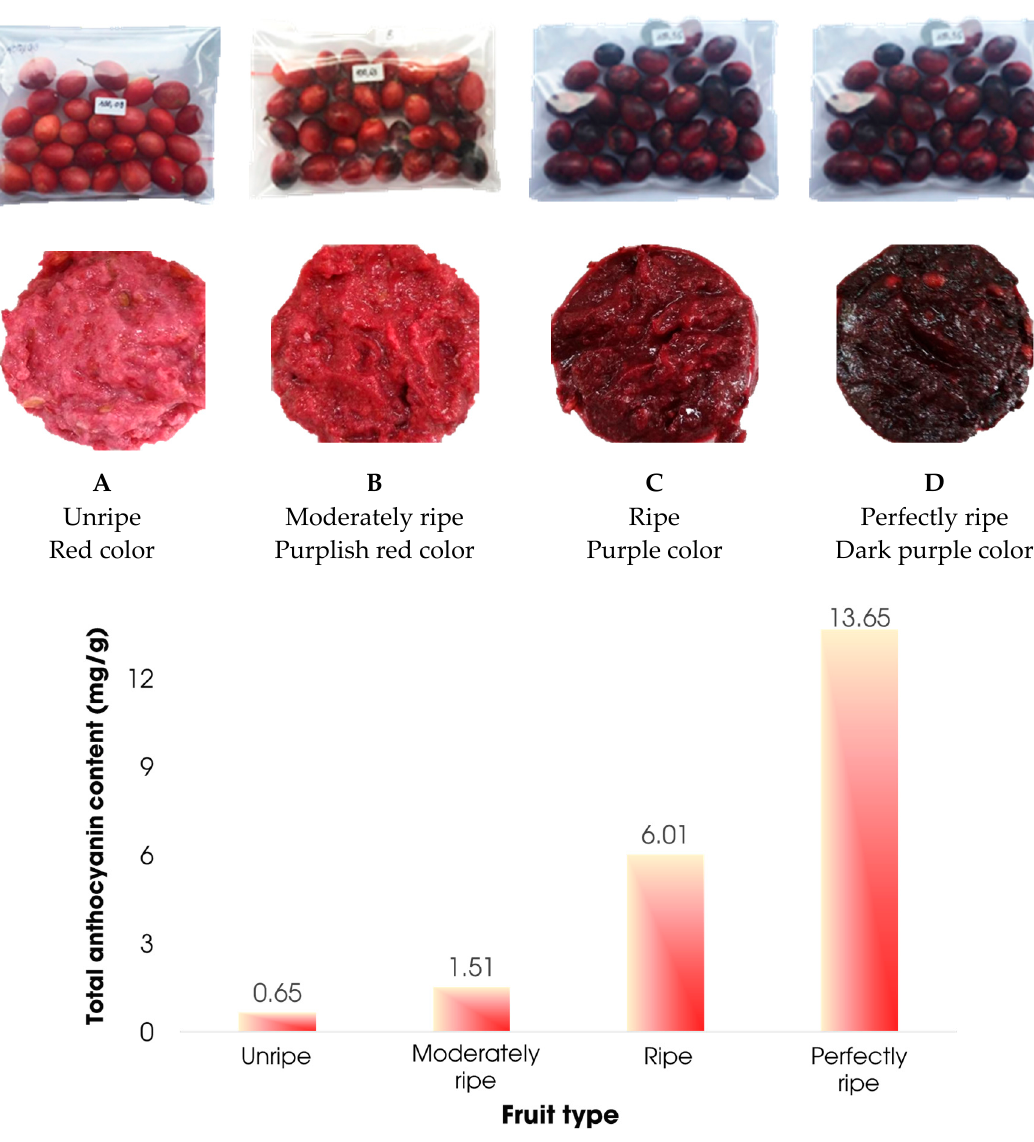
ff erent ripeness levels and extraction